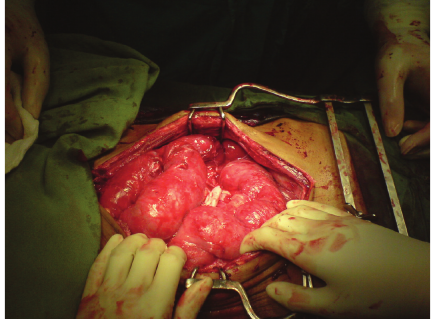
Figure 3: The abdominal contents after adhesiolysis.